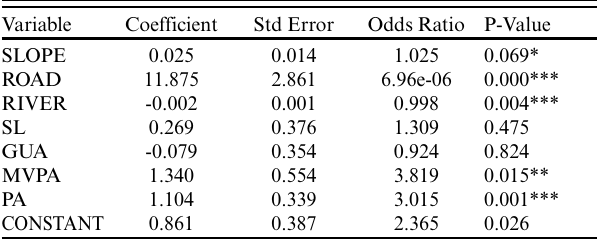
Table 3 . Logistic regression analysis of independent variables predicting likelihood of forest regrowth. Variable descriptions are provided in Table